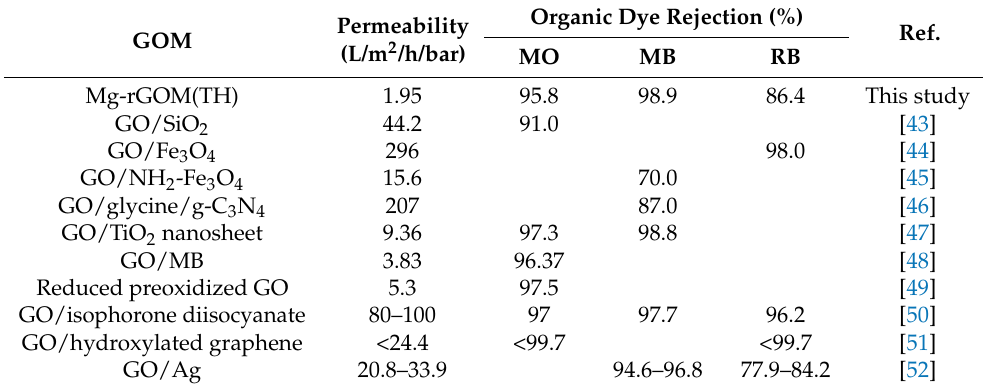
Table 3. Organic dye molecules used for evaluating nanofiltration performance of the GOM